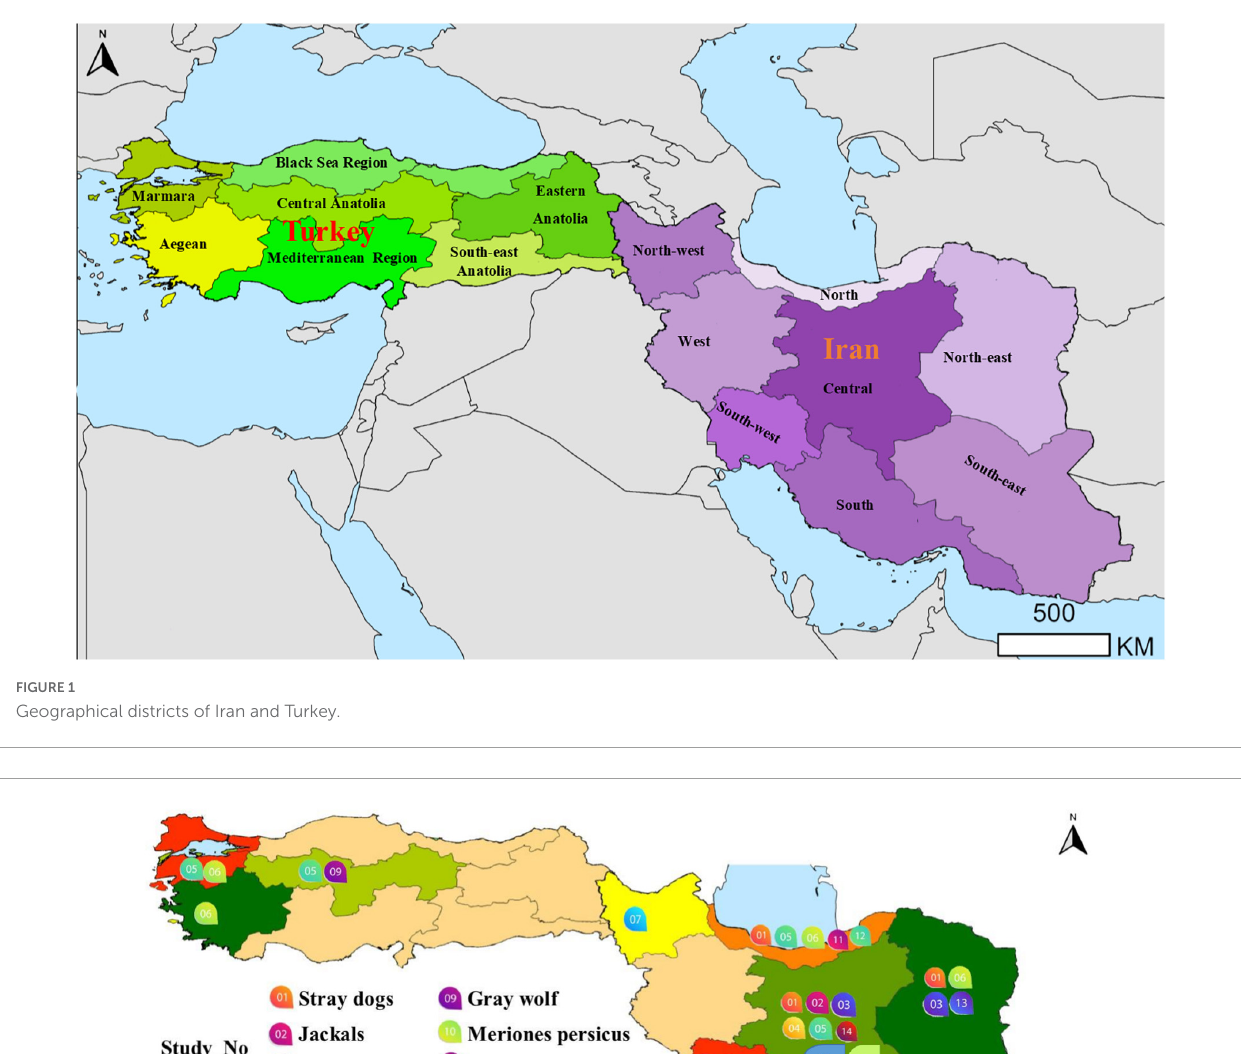
FIGURE2 The region of the detection of Trichinella infected human and animals (for more details, please refer to the main text).